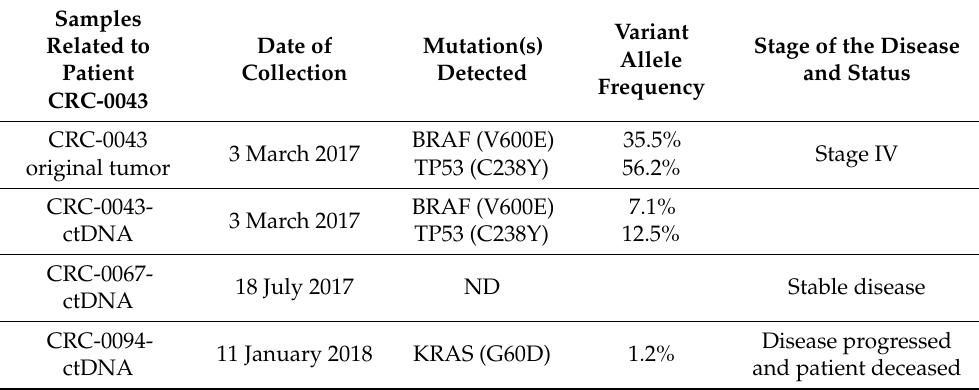
Table 3. Case report corresponding to a colorectal cancer patient from whom three longitudinal blood samples were collected and analyzed for the presence of pathological mutations (ND = not